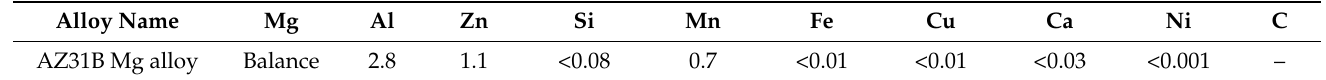
Table 1. Chemical composition of AZ31B (wt %).